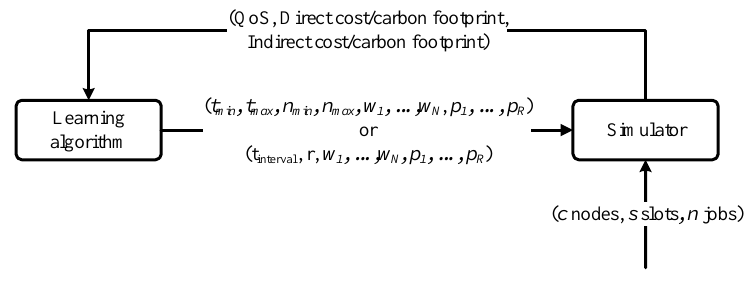
Figure 4. EECluster distal supervised learning